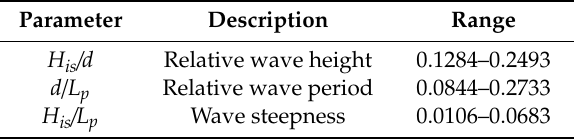
Table 2. Range of dimensionless input parameters.